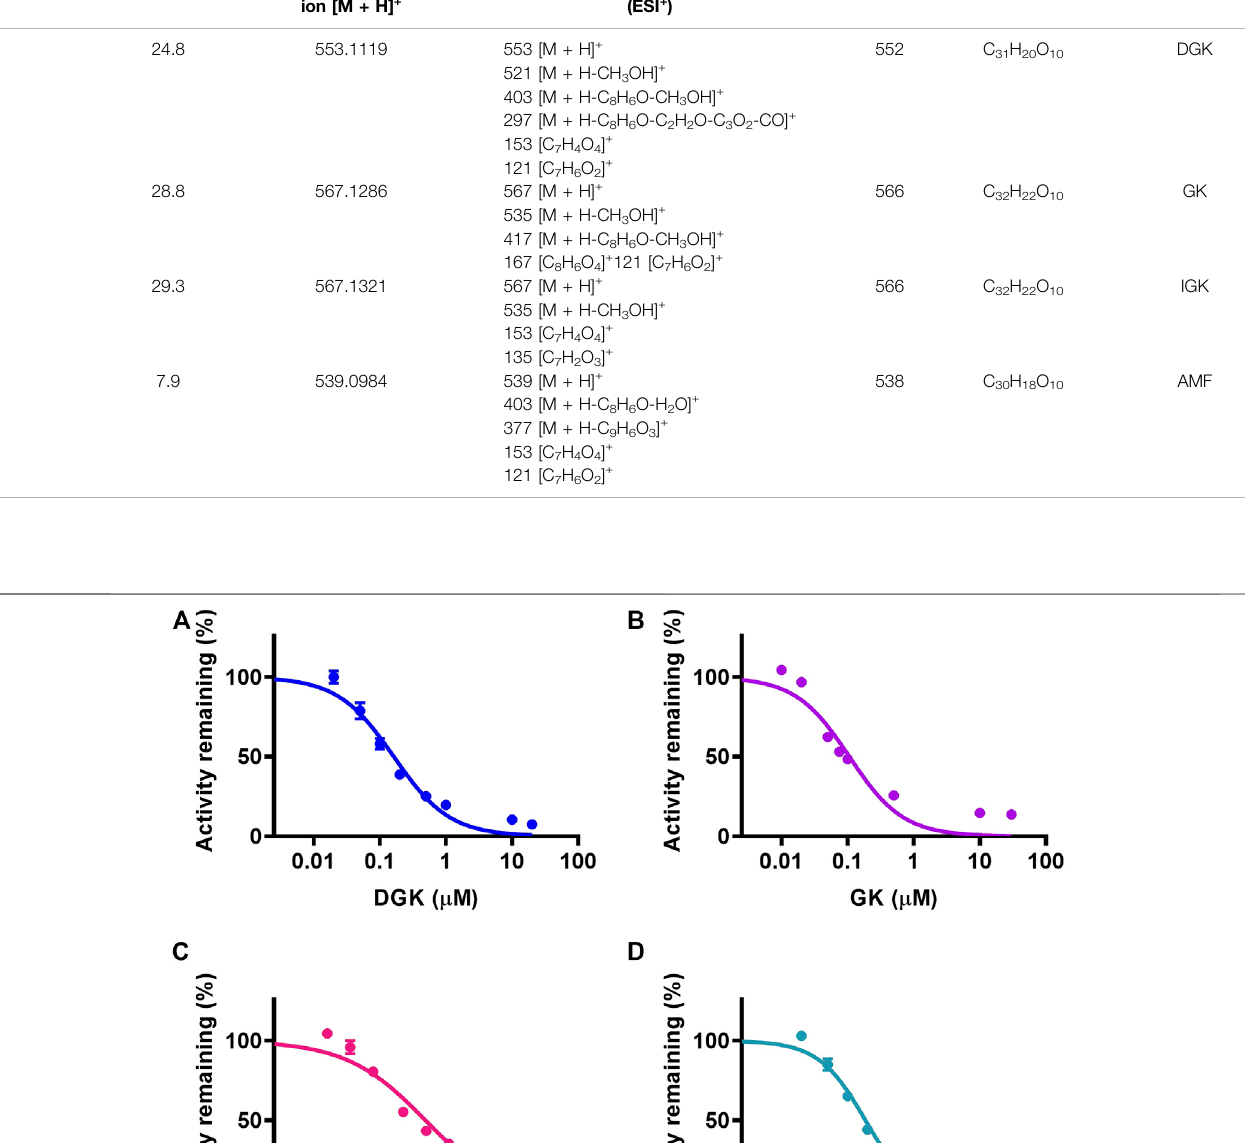
( Table 2 ). These results demonstrated that DGK, GK, IGK, and AMF functioned as strong inhibitors of CYP3A4 with the K i values ranging from 0.034 to 0.278 µM